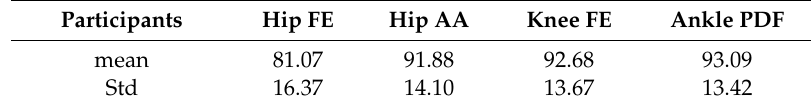
Table 4. Joint moment prediction performances for jack-knife cross-validation, evaluated by VAF (%). Participants